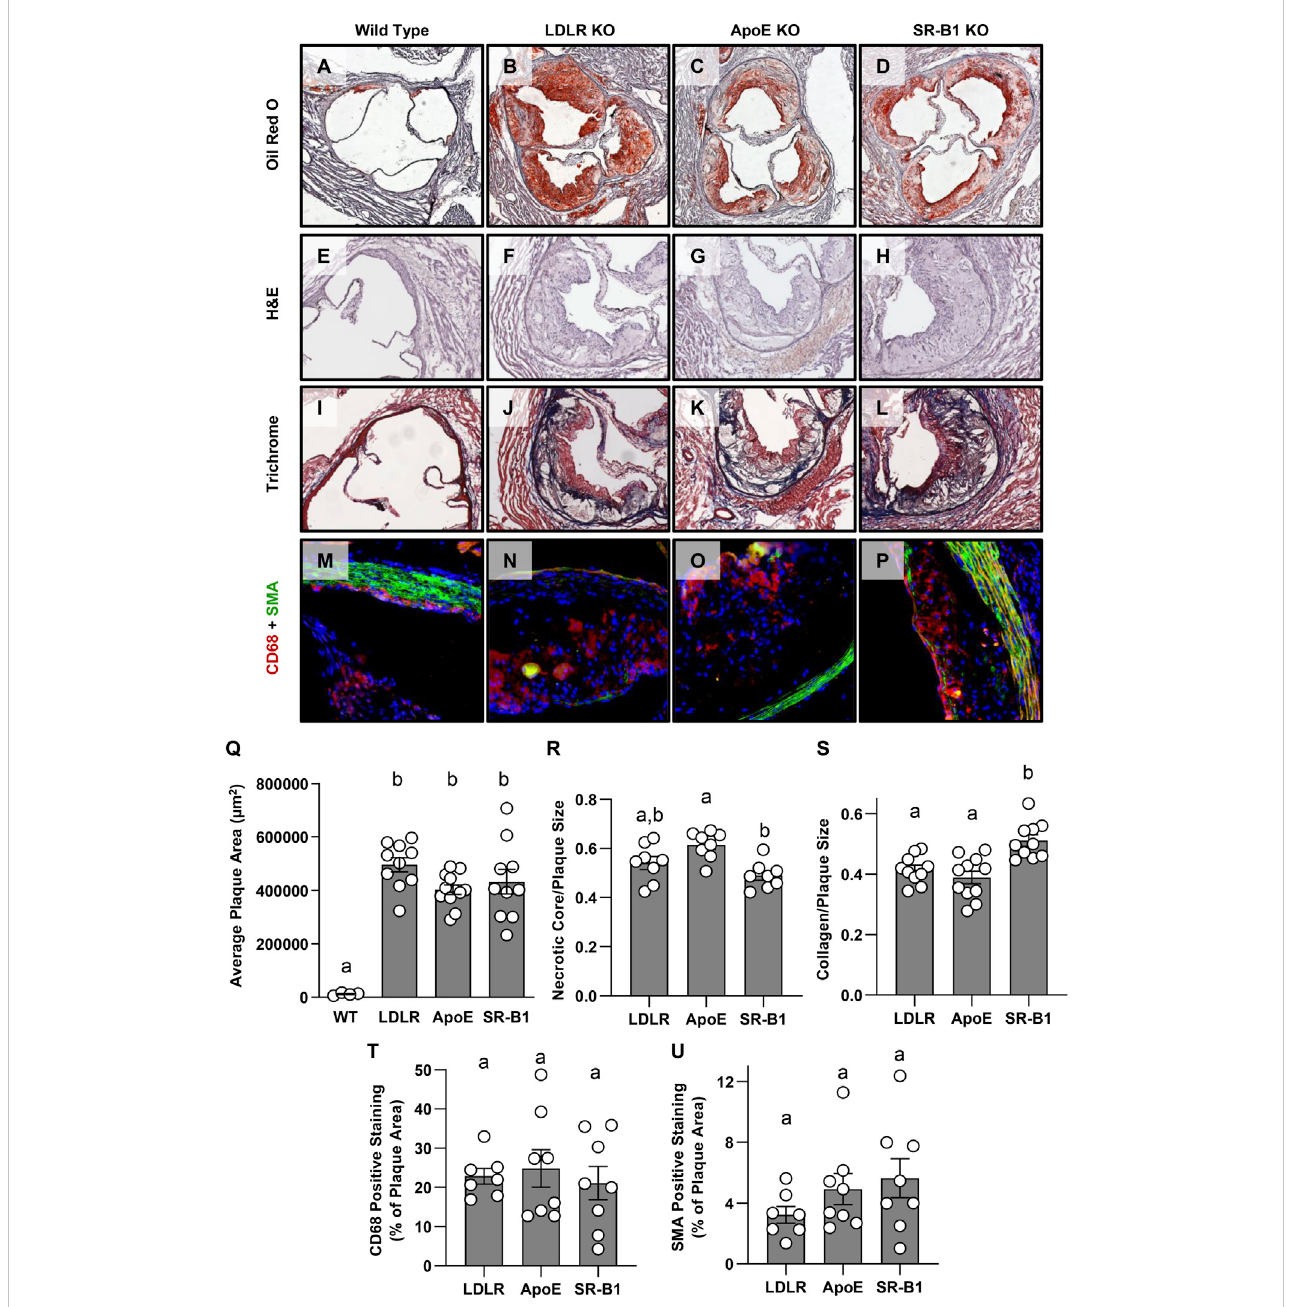
FIGURE 2 Sizeand compositionofaorticsinus atheroscleroticplaques inHFCC-fed female WT,LDLR KO, ApoEKO, and SR-B1 KOmice. Representative imagesof aseries of transverse cryosections of an aorticsinus from one mouseof the indicated genotypestained with oil red-O (A – D) , H&E (E – H) , Masson ’ s trichrome (I – L) or by immuno fl uorescence for CD68 (red) and smooth muscle actin (green) (M – P) are shown. (Q) Atherosclerotic plaque cross sectional areas at the aortic root. (R) Necrotic core size as a fraction of plaque size measured as acellular regions in H&E stained sections. (S) Collagen as a fraction of plaque size measured as blue-stained tissue in Masson ’ s trichrome-stained sections. (T) CD68-positive area as a fraction of plaque size as measured by immuno fl uorescence. (U) SMA-positive area as a fraction of plaque size as measured by immuno fl uorescence. Individual symbols represent data from individual mice and bars with error bars represent average ± SEM of each group. Only plaque size was measured in WT mice due to dif fi culty reproducibly identifying plaques in images stained for other parameters. Bars with different letters are statistically signi fi cantly different from one another by one-way ANOVA with Tukey ’ spost-hoctest. p values are (Q) : Overall ANOVA: p < 0.0001; multiple comparisons: p < 0.0001 for a vs. b; (R) : Overall ANOVA: p = 0.003; multiple comparisons: p = 0.0019 for a vs. b; (S) : Overall ANOVA: p = 0.0002; multiple comparisons: p < 0.005 for a vs. b; (T) : Overall ANOVA and multiple comparisons: p > 0.7 (not signi fi cant); (U) : Overall ANOVA and multiple comparisons: p > 0.25 (not signi fi